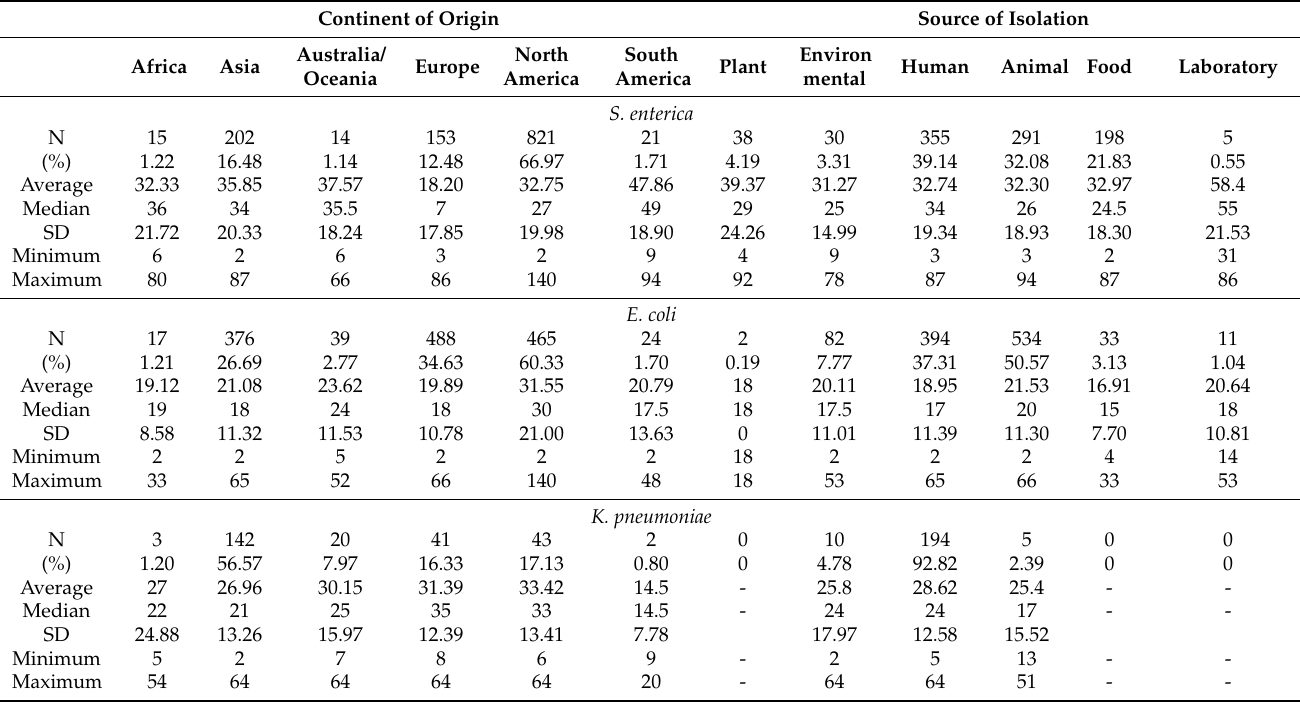
Table 1. Distribution of CRISPR spacers in the queried genomes, according to geographic origin and source of